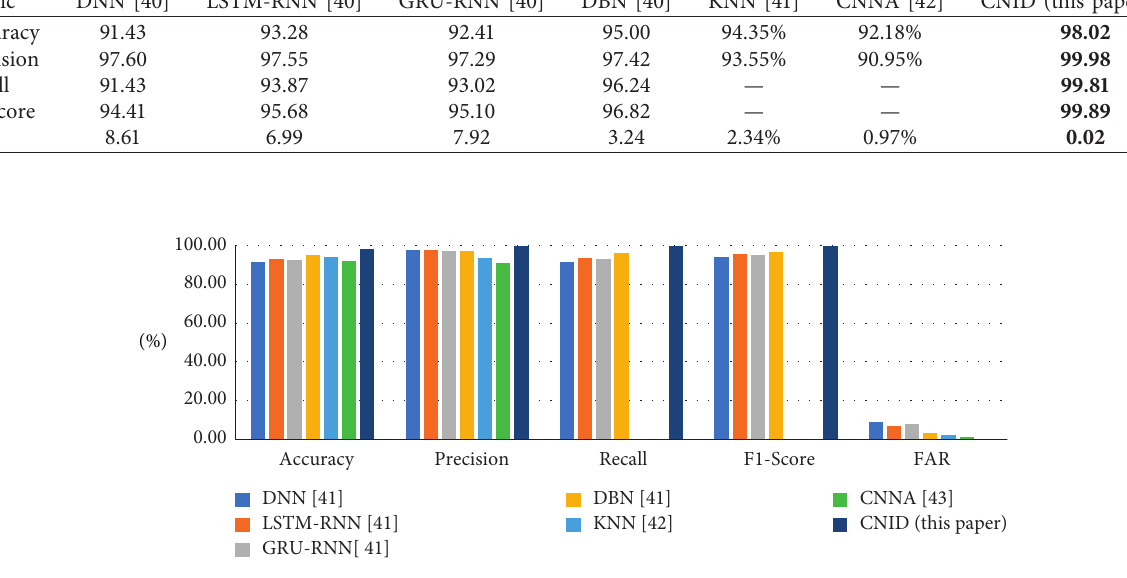
Figure 7: KDD-CUP 99 experiment result.